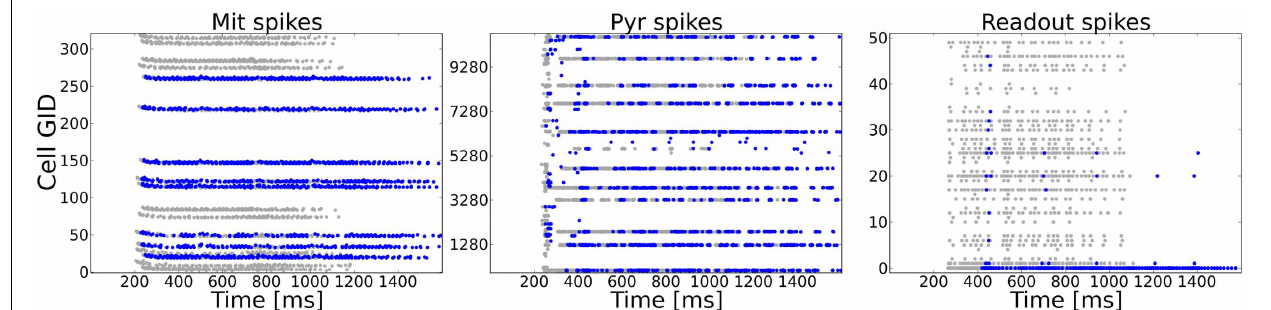
FIGURE 6 | Example activity shown as raster plots during pattern 0 in Task 4 (pattern completion). The system as trained to 50 complete patterns (as in Task 1) is exposed to an incomplete version of a training pattern in which 50% (randomly chosen) of the previously active ORs are silenced. The y-axis shows the cell number of the respective neuron type. Gray dots mark the activity during the training, blue dots show the activity during the test with the incomplete pattern. For the test pattern temporal dynamics of stimulation are more variable due to sniffing input as compared to the puff like input used during training. Left: MT spike